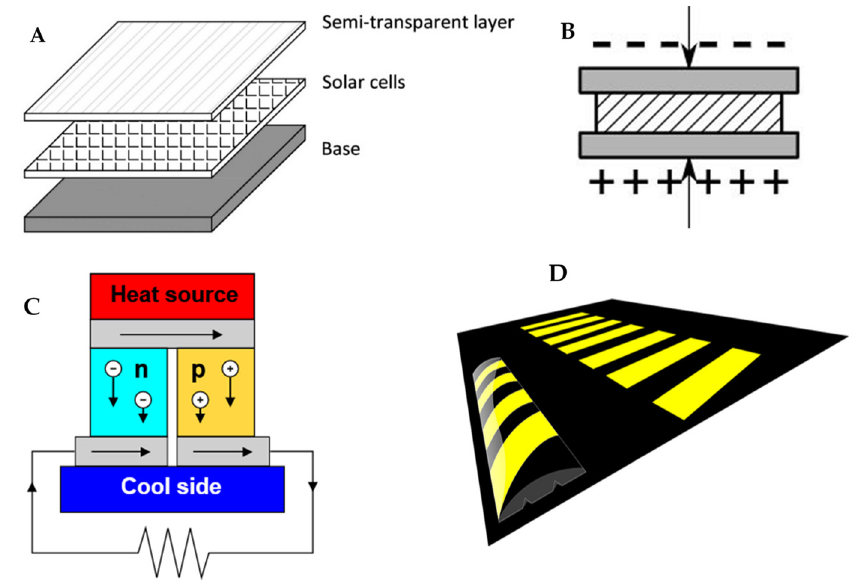
Figure 2. Examples of energy harvesting roads. ( A ) solar road; ( B ) piezoelectric material; ( C ) thermoelectric generator; ( D ) speed bump (traffic energy harvesting device).